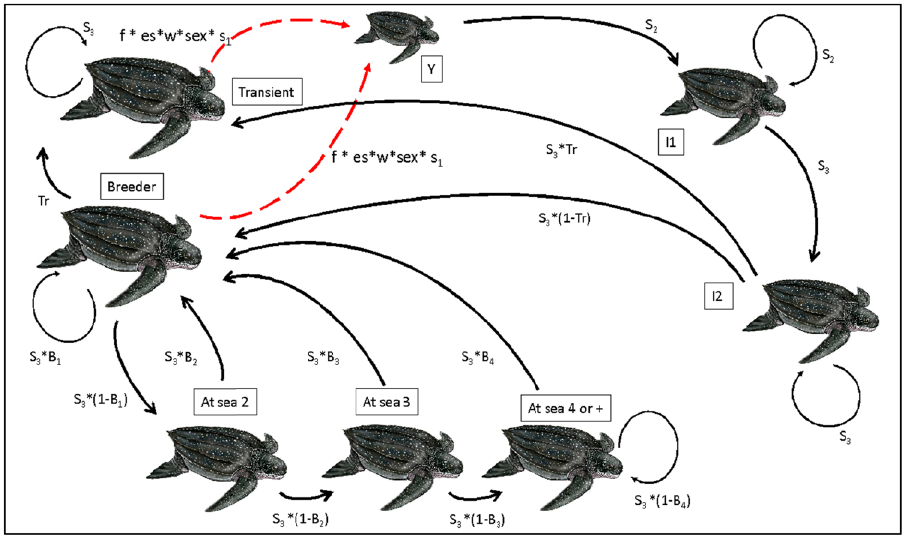
Figure 2. Life cycle of the eastern Pacific leatherback turtle based on eight life stages. Where “Y” stands for yearlings, “I1” juveniles until age of three, “I2” subadults between three and twelve years old, “Breeder” nesting females, “Transients” females marked in one nesting season and never seen again, “At sea 2” turtles at sea two years after nesting, “At sea 3” three years after nesting, “At sea 4 + ” four or more years after nesting. “F” eggs per female per season, “es” emerging success, “w”, survival to the water, “sex”, proportion of females, “Tr” probability of being a transient, “B i ” probability of breeding at year i, “S 1 ” survival in the first year of life, “S 2 ” survival between years 1–3, “S 3 ” survival of adults. The equation for hatchling production (f * es * w * fem) corresponds to the Costa Rican subpopulation. Hatchling production for México was: H = f * hw * fem, where “hw” was the number of hatchlings that reached the water in relation to clutch